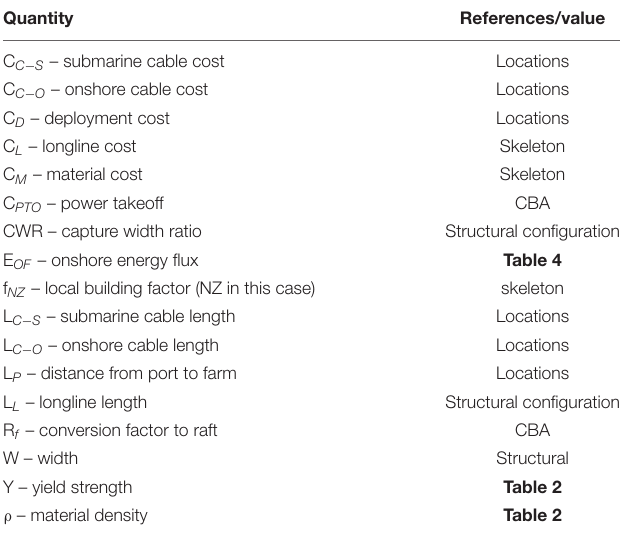
TABLE 2 | Cost Benefit Analysis notation and location of description in the Methods